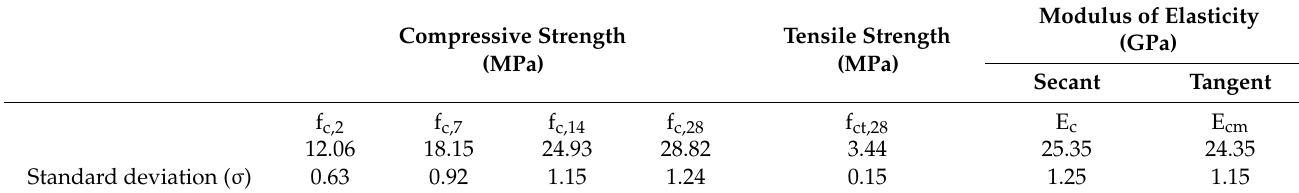
Table 4. The test results obtained on hardened concrete.